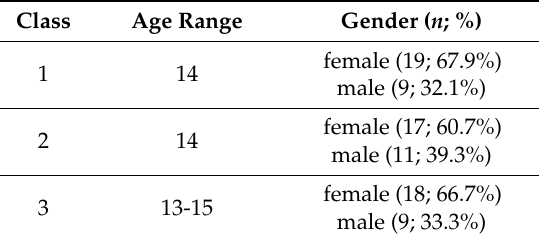
Table 1. Characterization of the